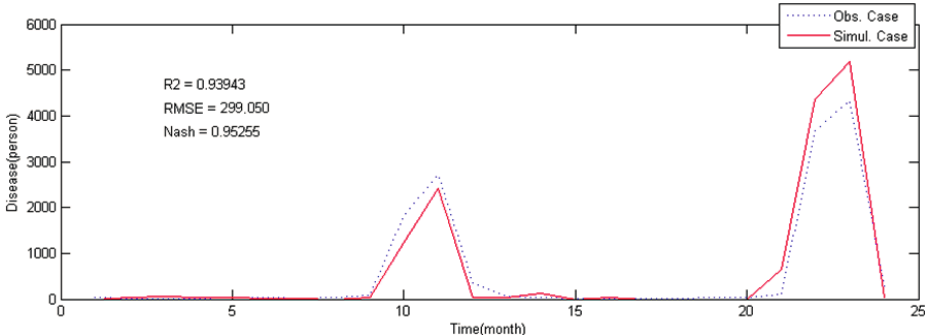
Figure 8. Validation result of scrub typhus incident model.